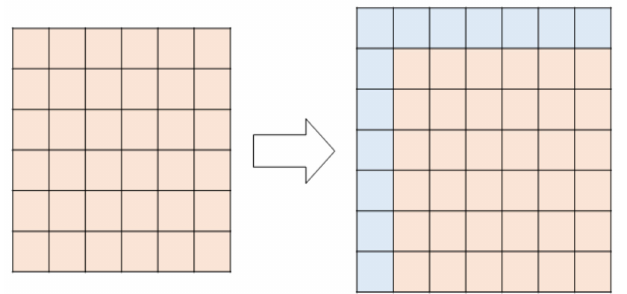
Figure 4. Creation of integral image.